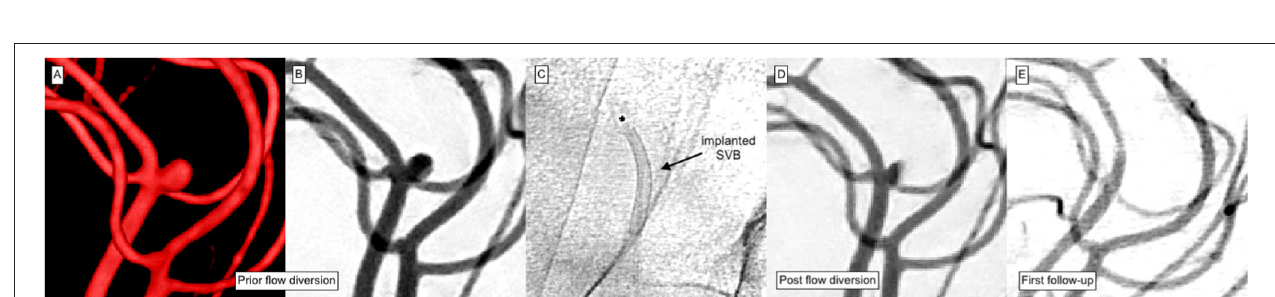
FIGURE 5 | Treatment of a peripheral left ACA aneurysm. The patient exhibited further aneurysms at the contralateral MCA bifurcation and the right SUCA. (A) 3D angiogram demonstrates an incidental peripherally located aneurysm of the left ACA. Interdisciplinary consent for treatment using the SVB was made. (B) The working projection was used to quantify the target lesion and the parent artery. The saccular aneurysm measured 2.3mm × 2.6mm. (C) The SVB was implanted using the Excelsior SL10 microcatheter (Stryker Neurovascular) for device delivery. SVB was positioned within the pericallosal artery; the aneurysm arising from the callosomarginal orifice was used to center the device. (D) Control injection revealed immediate reduction of aneurysmal perfusion. (E) The first follow-up after 5 months showed the exclusion of the aneurysm from the intracranial circulation. The covered branch remains patent but exhibits a slightly reduced diameter without delayed